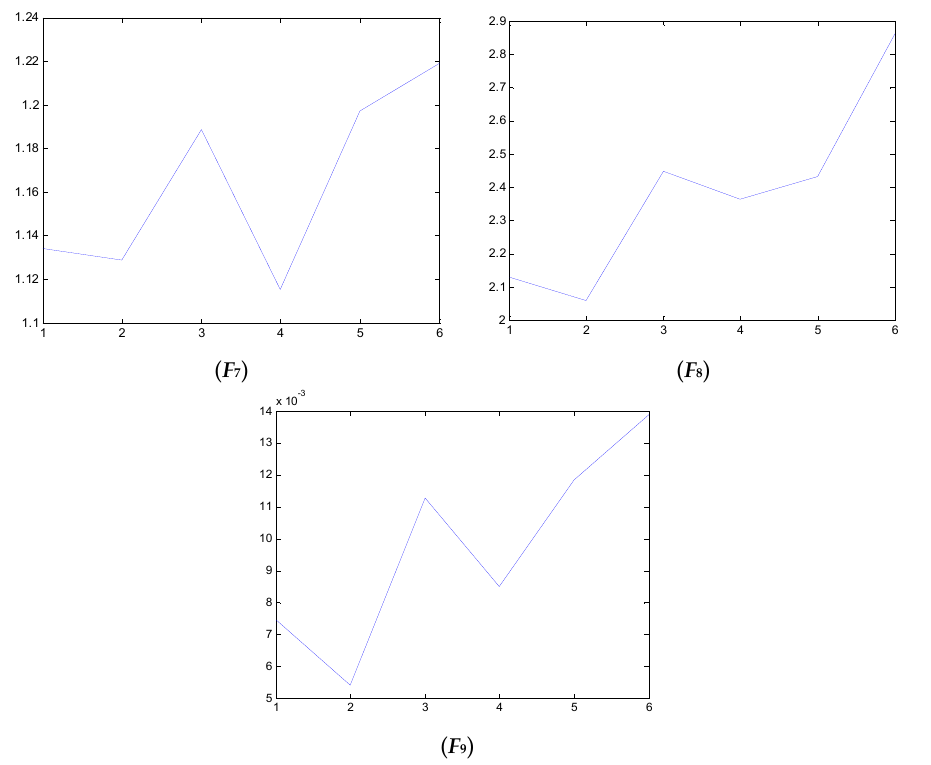
Figure 16. The analyzed results of A fan No. 2H sensor by F 7 , F 8 and F 9 .